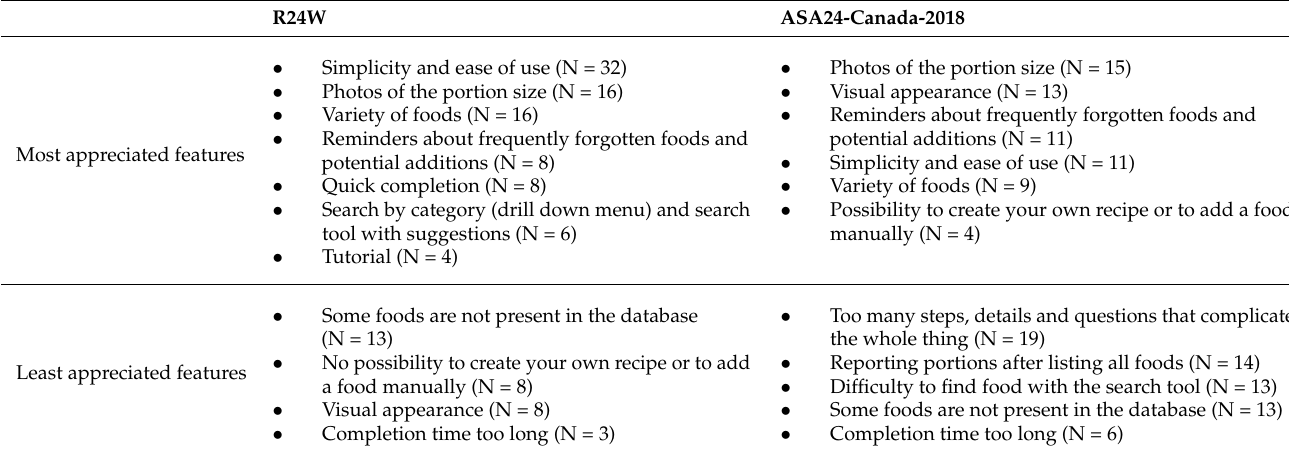
Table 4. Most and least appreciated features of the R24W and ASA24-Canada-2018 among the 68 study